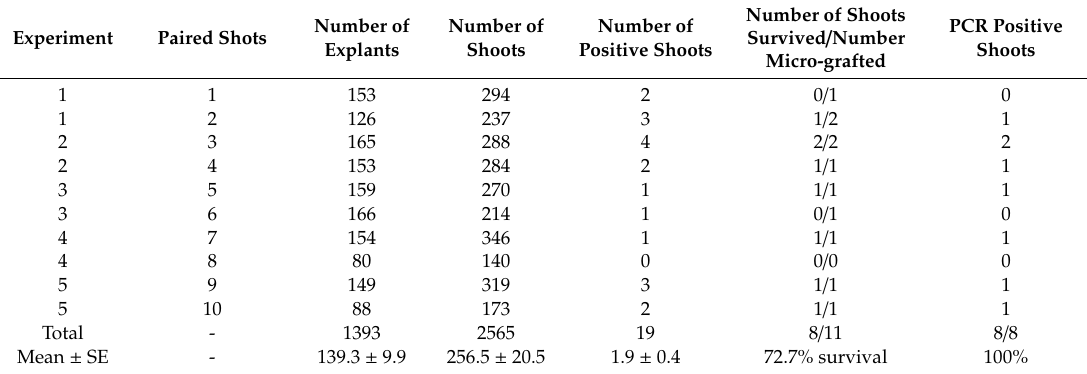
Table 1. Biolistic transformation of Citrus sinensis Osb. x Poncirus trifoliata L. Raf. (Carrizo citrange), the number of transgenic shoots produced, micro-grafted, and tested with PCR. Experiment